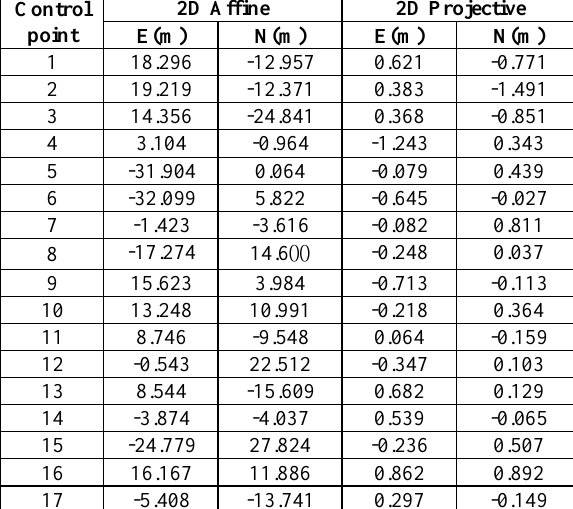
Table 16. The residual of control points of two kinds transformation.